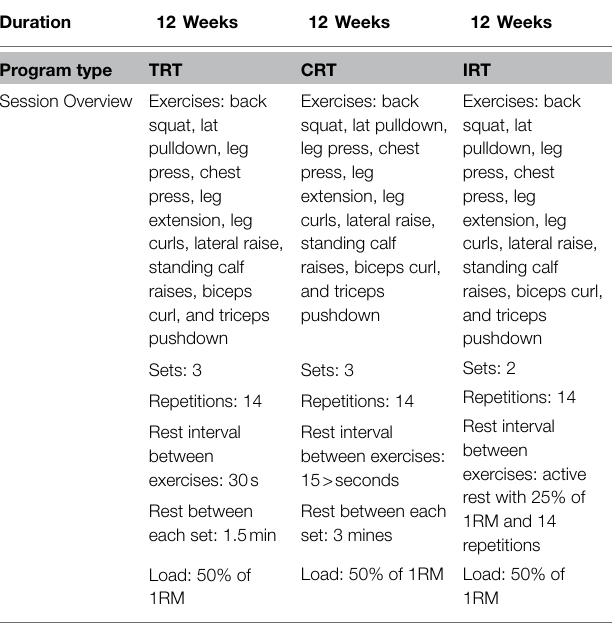
TABLE 1 | Exercises, sets, repetitions, and rest intervals between exercises and sets and a load of exercise for each weekly session in the TRT, CRT, and IRT